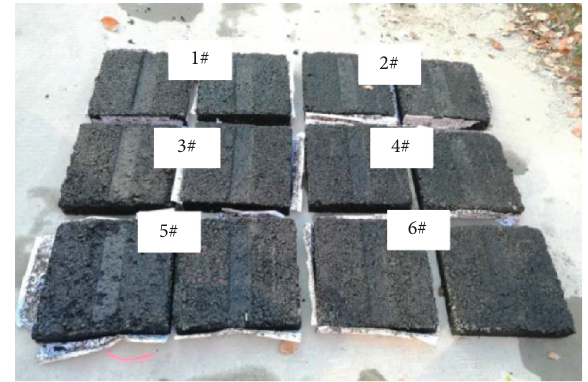
Figure 9: Rutting test